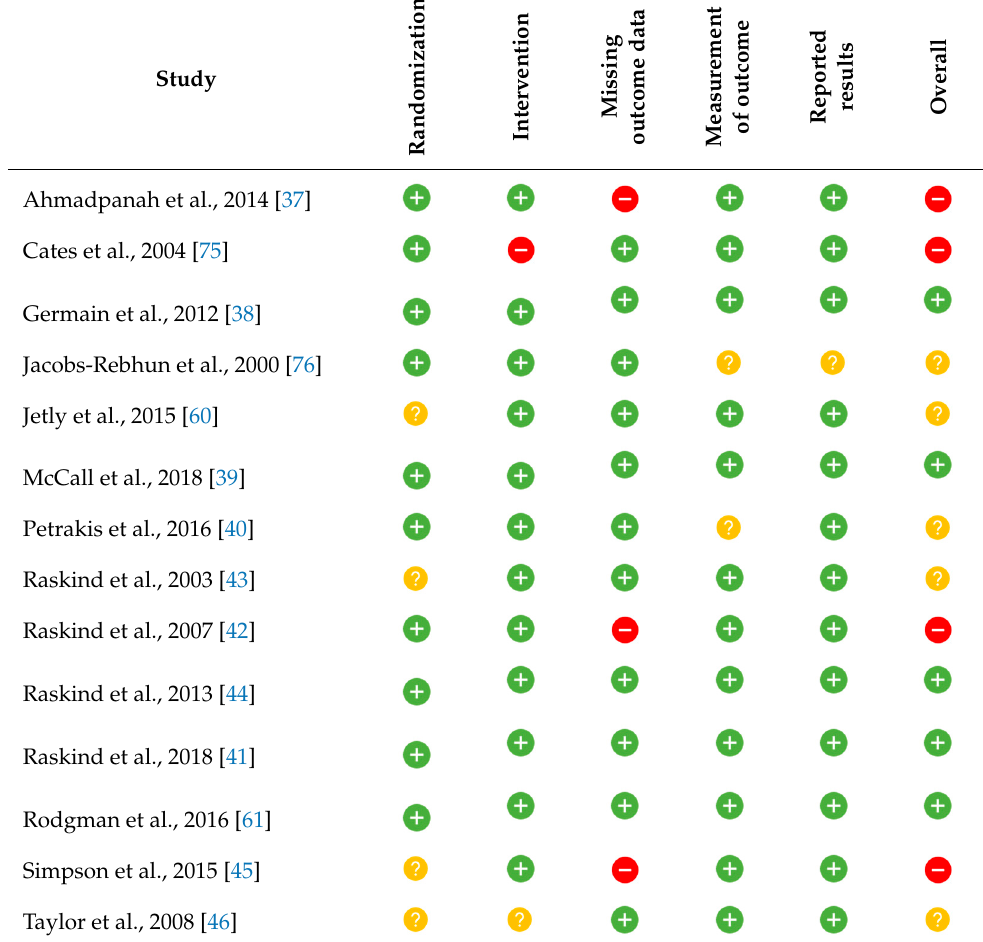
Table 2. Risk of Bias in the Included Table 2. Risk of Bias in the Included Studies. Randomization : biases that unfold in the randomization process. Intervention : biases due to deviations Randomization : biases that unfold in the randomization process. Intervention : biases due to deviations from intended interventions. Missing outcome data: biases due to missing outcome data. Measure- from intended interventions. Missing outcome data: biases due to missing outcome data. Measure- Randomization : biases that unfold in the randomization process. Intervention : biases due to deviations Randomization : biases that unfold in the randomization process. Intervention : biases due to deviations Randomization : biases that unfold in the randomization process. Intervention : biases due to deviations Randomization : biases that unfold in the randomization process. Intervention : biases due to deviations ment of outcome : biases in measurement of outcome. Reported results : biases in the selection process ment of outcome : biases in measurement of outcome. Reported results : biases in the selection process from intended interventions. Missing outcome data: biases due to missing outcome data. Measure- from intended interventions. Missing outcome data: biases due to missing outcome data. Measure- from intended interventions. Missing outcome data: biases due to missing outcome data. Measure- from intended interventions. Missing outcome data: biases due to missing outcome data. Measure- from intended interventions. Missing outcome data: biases due to missing outcome data. Measure- Randomization : biases that unfold in the randomization process. Intervention : biases due to deviations of reported results. Overall : skewness assessment of the study in its entirety. : Low risk : ment of outcome : biases in measurement of outcome. Reported results : biases in the selection process ment of outcome : biases in measurement of outcome. Reported results : biases in the selection process ment of outcome : biases in measurement of outcome. Reported results : biases in the selection process ment of outcome : biases in measurement of outcome. Reported results : biases in the selection process of reported results. Overall : skewness assessment of the study in its entirety. : Low risk : ment of outcome : biases in measurement of outcome. Reported results : biases in the selection process ment of outcome : biases in measurement of outcome. Reported results : biases in the selection process from intended interventions. Missing outcome data: biases due to missing outcome data. Measure- Randomization : biases that unfold in the randomization process. Intervention : biases due to deviations Randomization : biases that unfold in the randomization process. Intervention : biases due to deviations of reported results. Overall : skewness assessment of the study in its entirety. of reported results. Overall : skewness assessment of the study in its entirety. of reported results. Overall : skewness assessment of the study in its entirety. : Low risk : of reported results. Overall : skewness assessment of the study in its entirety. : Low risk : ment of outcome : biases in measurement of outcome. Reported results : biases in the selection process ment of outcome : biases in measurement of outcome. Reported results : biases in the selection process Randomization : biases that unfold in the randomization process. Intervention : biases due to deviations Randomization : biases that unfold in the randomization process. Intervention : biases due to deviations of reported results. Overall : skewness assessment of the study in its entirety. Randomization : biases that unfold in the randomization process. Intervention : biases due to deviations from intended interventions. Missing outcome data: biases due to missing outcome data. Measure- from intended interventions. Missing outcome data: biases due to missing outcome data. Measure- from intended interventions. Missing outcome data: biases due to missing outcome data. Measure- from intended interventions. Missing outcome data: biases due to missing outcome data. Measure- Uncertain of reported results. Overall : skewness assessment of the study in its entirety. of reported results. Overall : skewness assessment of the study in its entirety. from intended interventions. Missing outcome data: biases due to missing outcome data. Measure- ment of outcome : biases in measurement of outcome. Reported results : biases in the selection process ment of outcome : biases in measurement of outcome. Reported results : biases in the selection process Randomization : biases that unfold in the randomization process. Intervention : biases due to deviations Randomization : biases that unfold in the randomization process. Intervention : biases due to deviations Randomization : biases that unfold in the randomization process. Intervention : biases due to deviations ment of outcome : biases in measurement of outcome. Reported results : biases in the selection process ment of outcome : biases in measurement of outcome. Reported results : biases in the selection process ment of outcome : biases in measurement of outcome. Reported results : biases in the selection process from intended interventions. Missing outcome data: biases due to missing outcome data. Measure- from intended interventions. Missing outcome data: biases due to missing outcome data. Measure- from intended interventions. Missing outcome data: biases due to missing outcome data. Measure- of reported results. Overall : skewness assessment of the study in its entirety. : Low risk : of reported results. Overall : skewness assessment of the study in its entirety. : Low risk : of reported results. Overall : skewness assessment of the study in its entirety. : Low risk : of reported results. Overall : skewness assessment of the study in its entirety. : Low risk : ment of outcome : biases in measurement of outcome. Reported results : biases in the selection process ment of outcome : biases in measurement of outcome. Reported results : biases in the selection process ment of outcome : biases in measurement of outcome. Reported results : biases in the selection process of reported results. Overall : skewness assessment of the study in its entirety. : Low risk : from intended interventions. Missing outcome data: biases due to missing outcome data. Measure- from intended interventions. Missing outcome data: biases due to missing outcome data. Measure- Uncertain : High risk. Uncertain : High risk. Uncertain : High risk. Randomization : biases that unfold in the randomization process. Intervention : biases due to deviations Randomization : biases that unfold in the randomization process. Intervention : biases due to deviations Randomization : biases that unfold in the randomization process. Intervention : biases due to deviations Randomization : biases that unfold in the randomization process. Intervention : biases due to deviations of reported results. Overall : skewness assessment of the study in its entirety. of reported results. Overall : skewness assessment of the study in its entirety. ment of outcome : biases in measurement of outcome. Reported results : biases in the selection process ment of outcome : biases in measurement of outcome. Reported results : biases in the selection process ment of outcome : biases in measurement of outcome. Reported results : biases in the selection process Randomization : biases that unfold in the randomization process. Intervention : biases due to deviations Randomization : biases that unfold in the randomization process. Intervention : biases due to deviations from intended interventions. Missing outcome data: biases due to missing outcome data. Measure- from intended interventions. Missing outcome data: biases due to missing outcome data. Measure- from intended interventions. Missing outcome data: biases due to missing outcome data. Measure- from intended interventions. Missing outcome data: biases due to missing outcome data. Measure- from intended interventions. Missing outcome data: biases due to missing outcome data. Measure- from intended interventions. Missing outcome data: biases due to missing outcome data. Measure- of reported results. Overall : skewness assessment of the study in its entirety. of reported results. Overall : skewness assessment of the study in its entirety. : Low risk : ment of outcome : biases in measurement of outcome. Reported results : biases in the selection process ment of outcome : biases in measurement of outcome. Reported results : biases in the selection process ment of outcome : biases in measurement of outcome. Reported results : biases in the selection process ment of outcome : biases in measurement of outcome. Reported results : biases in the selection process Randomization : biases that unfold in the randomization process. Intervention : biases due to deviations Randomization : biases that unfold in the randomization process. Intervention : biases due to deviations Randomization : biases that unfold in the randomization process. Intervention : biases due to deviations Randomization : biases that unfold in the randomization process. Intervention : biases due to deviations ment of outcome : biases in measurement of outcome. Reported results : biases in the selection process ment of outcome : biases in measurement of outcome. Reported results : biases in the selection process from intended interventions. Missing outcome data: biases due to missing outcome data. Measure- from intended interventions. Missing outcome data: biases due to missing outcome data. Measure- from intended interventions. Missing outcome data: biases due to missing outcome data. Measure- from intended interventions. Missing outcome data: biases due to missing outcome data. Measure- of reported results. Overall : skewness assessment of the study in its entirety. of reported results. Overall : skewness assessment of the study in its entirety. : Low risk : of reported results. Overall : skewness assessment of the study in its entirety. : Low risk : of reported results. Overall : skewness assessment of the study in its entirety. : Low risk : Randomization : biases that unfold in the randomization process. Intervention : biases due to deviations Randomization : biases that unfold in the randomization process. Intervention : biases due to deviations Randomization : biases that unfold in the randomization process. Intervention : biases due to deviations Randomization : biases that unfold in the randomization process. Intervention : biases due to deviations of reported results. Overall : skewness assessment of the study in its entirety. : Low risk : of reported results. Overall : skewness assessment of the study in its entirety. ment of outcome : biases in measurement of outcome. Reported results : biases in the selection process ment of outcome : biases in measurement of outcome. Reported results : biases in the selection process ment of outcome : biases in measurement of outcome. Reported results : biases in the selection process ment of outcome : biases in measurement of outcome. Reported results : biases in the selection process from intended interventions. Missing outcome data: biases due to missing outcome data. Measure- from intended interventions. Missing outcome data: biases due to missing outcome data. Measure- from intended interventions. Missing outcome data: biases due to missing outcome data. Measure- from intended interventions. Missing outcome data: biases due to missing outcome data. Measure- Uncertain : High risk. Randomization : biases that unfold in the randomization process. Intervention : biases due to deviations Randomization : biases that unfold in the randomization process. Intervention : biases due to deviations Randomization : biases that unfold in the randomization process. Intervention : biases due to deviations Randomization : biases that unfold in the randomization process. Intervention : biases due to deviations of reported results. Overall : skewness assessment of the study in its entirety. of reported results. Overall : skewness assessment of the study in its entirety. of reported results. Overall : skewness assessment of the study in its entirety. of reported results. Overall : skewness assessment of the study in its entirety. : Low risk : ment of outcome : biases in measurement of outcome. Reported results : biases in the selection process ment of outcome : biases in measurement of outcome. Reported results : biases in the selection process ment of outcome : biases in measurement of outcome. Reported results : biases in the selection process ment of outcome : biases in measurement of outcome. Reported results : biases in the selection process from intended interventions. Missing outcome data: biases due to missing outcome data. Measure- from intended interventions. Missing outcome data: biases due to missing outcome data. Measure- from intended interventions. Missing outcome data: biases due to missing outcome data. Measure- from intended interventions. Missing outcome data: biases due to missing outcome data. Measure- Randomization : biases that unfold in the randomization process. Intervention : biases due to deviations Uncertain Randomization : biases that unfold in the randomization process. Intervention : biases due to deviations Randomization : biases that unfold in the randomization process. Intervention : biases due to deviations Randomization : biases that unfold in the randomization process. Intervention : biases due to deviations of reported results. Overall : skewness assessment of the study in its entirety. : Low risk : of reported results. Overall : skewness assessment of the study in its entirety. : Low risk : of reported results. Overall : skewness assessment of the study in its entirety. : Low risk : of reported results. Overall : skewness assessment of the study in its entirety. : Low risk : ment of outcome : biases in measurement of outcome. Reported results : biases in the selection process ment of outcome : biases in measurement of outcome. Reported results : biases in the selection process ment of outcome : biases in measurement of outcome. Reported results : biases in the selection process ment of outcome : biases in measurement of outcome. Reported results : biases in the selection process Randomization : biases that unfold in the randomization process. Intervention : biases due to deviations from intended interventions. Missing outcome data: biases due to missing outcome data. Measure- from intended interventions. Missing outcome data: biases due to missing outcome data. Measure- from intended interventions. Missing outcome data: biases due to missing outcome data. Measure- from intended interventions. Missing outcome data: biases due to missing outcome data. Measure- from intended interventions. Missing outcome data: biases due to missing outcome data. Measure- from intended interventions. Missing outcome data: biases due to missing outcome data. Measure- ment of outcome : biases in measurement of outcome. Reported results : biases in the selection process Uncertain : High risk. Uncertain : High risk. of reported results. Overall : skewness assessment of the study in its entirety. : Low risk : of reported results. Overall : skewness assessment of the study in its entirety. : Low risk : of reported results. Overall : skewness assessment of the study in its entirety. : Low risk : of reported results. Overall : skewness assessment of the study in its entirety. : Low risk : ment of outcome : biases in measurement of outcome. Reported results : biases in the selection process ment of outcome : biases in measurement of outcome. Reported results : biases in the selection process ment of outcome : biases in measurement of outcome. Reported results : biases in the selection process ment of outcome : biases in measurement of outcome. Reported results : biases in the selection process Randomization : biases that unfold in the randomization process. Intervention : biases due to deviations Randomization : biases that unfold in the randomization process. Intervention : biases due to deviations Randomization : biases that unfold in the randomization process. Intervention : biases due to deviations ment of outcome : biases in measurement of outcome. Reported results : biases in the selection process Taylor et al., 2008 [46] from intended interventions. Missing outcome data: biases due to missing outcome data. Measure- from intended interventions. Missing outcome data: biases due to missing outcome data. Measure- from intended interventions. Missing outcome data: biases due to missing outcome data. Measure- from intended interventions. Missing outcome data: biases due to missing outcome data. Measure- of reported results. Overall : skewness assessment of the study in its entirety. Uncertain : High risk. Uncertain : High risk. Uncertain : High risk. Uncertain : High risk. Taylor et al., 2008 [46] of reported results. Overall : skewness assessment of the study in its entirety. : Low risk : ment of outcome : biases in measurement of outcome. Reported results : biases in the selection process ment of outcome : biases in measurement of outcome. Reported results : biases in the selection process ment of outcome : biases in measurement of outcome. Reported results : biases in the selection process ment of outcome : biases in measurement of outcome. Reported results : biases in the selection process Randomization : biases that unfold in the randomization process. Intervention : biases due to deviations Randomization : biases that unfold in the randomization process. Intervention : biases due to deviations Randomization : biases that unfold in the randomization process. Intervention : biases due to deviations Uncertain Randomization : biases that unfold in the randomization process. Intervention : biases due to deviations Randomization : biases that unfold in the randomization process. Intervention : biases due to deviations Randomization : biases that unfold in the randomization process. Intervention : biases due to deviations from intended interventions. Missing outcome data: biases due to missing outcome data. Measure- from intended interventions. Missing outcome data: biases due to missing outcome data. Measure- from intended interventions. Missing outcome data: biases due to missing outcome data. Measure- Uncertain : High risk. from intended interventions. Missing outcome data: biases due to missing outcome data. Measure- of reported results. Overall : skewness assessment of the study in its entirety. of reported results. Overall : skewness assessment of the study in its entirety. : Low risk : of reported results. Overall : skewness assessment of the study in its entirety. : Low risk : of reported results. Overall : skewness assessment of the study in its entirety. : Low risk : from intended interventions. Missing outcome data: biases due to missing outcome data. Measure- from intended interventions. Missing outcome data: biases due to missing outcome data. Measure- ment of outcome : biases in measurement of outcome. Reported results : biases in the selection process ment of outcome : biases in measurement of outcome. Reported results : biases in the selection process ment of outcome : biases in measurement of outcome. Reported results : biases in the selection process Randomization : biases that unfold in the randomization process. Intervention : biases due to deviations Randomization : biases that unfold in the randomization process. Intervention : biases due to deviations ment of outcome : biases in measurement of outcome. Reported results : biases in the selection process ment of outcome : biases in measurement of outcome. Reported results : biases in the selection process ment of outcome : biases in measurement of outcome. Reported results : biases in the selection process from intended interventions. Missing outcome data: biases due to missing outcome data. Measure- from intended interventions. Missing outcome data: biases due to missing outcome data. Measure- of reported results. Overall : skewness assessment of the study in its entirety. : Low risk : of reported results. Overall : skewness assessment of the study in its entirety. : Low risk : of reported results. Overall : skewness assessment of the study in its entirety. : Low risk : of reported results. Overall : skewness assessment of the study in its entirety. : Low risk : of reported results. Overall : skewness assessment of the study in its entirety. : Low risk : of reported results. Overall : skewness assessment of the study in its entirety. : Low risk : ment of outcome : biases in measurement of outcome. Reported results : biases in the selection process ment of outcome : biases in measurement of outcome. Reported results : biases in the selection process Uncertain : High risk. Uncertain : High risk. Uncertain : High risk. Uncertain : High risk. Uncertain : High risk. Uncertain : High risk. of reported results. Overall : skewness assessment of the study in its entirety. : Low risk : Uncertain : High risk. 3.5. Results at the End of Treatment The results of the 15 pharmacological interventions after treatment (14 studies, N = 830) showed an overall effect size of g = 0.50 (95% CI = 0.14–0.87, p = 0.007). See Figure 2. It should be noted that there was large variation in the effect sizes between the different studies manifested by a Cochran’s Q of 83.1 ( df = 14, p < 0.01), which indicates significant heterogeneity. The I 2 suggested that 83.2% of the variation in effect sizes reflects real var- iation. Following the Knapp–Hartung adjustment [72], the 95% CI interval became wider (0.06–0.95, p = 0.029), but the overall effect size was still significant. When only including studies with low risk of bias (k = 5), the overall effect size became non-significant ( g = 0.11, 95% CI = − 0.44–0.67, p = 0.690). of reported results. Overall : skewness assessment of the study in its entirety. : Low risk : Uncertain : High risk. 3.5. Results at the End of Treatment The results of the 15 pharmacological interventions after treatment (14 studies, N = 830) showed an overall effect size of g = 0.50 (95% CI = 0.14–0.87, p = 0.007). See Figure 2. It should be noted that there was large variation in the effect sizes between the different studies manifested by a Cochran’s Q of 83.1 ( df = 14, p < 0.01), which indicates significant heterogeneity. The I 2 suggested that 83.2% of the variation in effect sizes reflects real var- iation. Following the Knapp–Hartung adjustment [72], the 95% CI interval became wider (0.06–0.95, p = 0.029), but the overall effect size was still significant. When only including studies with low risk of bias (k = 5), the overall effect size became non-significant ( g = 0.11, 95% CI = − 0.44–0.67, p = 0.690). 3.5. Results at the End of Treatment The results of the 15 pharmacological interventions after treatment (14 studies, N = 830) showed an overall effect size of g = 0.50 (95% CI = 0.14–0.87, p = 0.007). See Figure 2. It should be noted that there was large variation in the effect sizes between the different studies manifested by a Cochran’s Q of 83.1 ( df = 14, p < 0.01), which indicates significant heterogeneity. The I 2 suggested that 83.2% of the variation in effect sizes reflects real var- iation. Following the Knapp–Hartung adjustment [72], the 95% CI interval became wider (0.06–0.95, p = 0.029), but the overall effect size was still significant. When only including studies with low risk of bias (k = 5), the overall effect size became non-significant ( g = 0.11, 95% CI = − 0.44–0.67, p = 0.690). 3.5. Results at the End of Treatment The results of the 15 pharmacological interventions after treatment (14 studies, N = 830) showed an overall effect size of g = 0.50 (95% CI = 0.14–0.87, p = 0.007). See Figure 2. It should be noted that there was large variation in the effect sizes between the different studies manifested by a Cochran’s Q of 83.1 ( df = 14, p < 0.01), which indicates significant heterogeneity. The I 2 suggested that 83.2% of the variation in effect sizes reflects real var- iation. Following the Knapp–Hartung adjustment [72], the 95% CI interval became wider (0.06–0.95, p = 0.029), but the overall effect size was still significant. When only including studies with low risk of bias (k = 5), the overall effect size became non-significant ( g = 0.11, 95% CI = − 0.44–0.67, p = 0.690). 3.5. Results at the End of Treatment The results of the 15 pharmacological interventions after treatment (14 studies, N = 830) showed an overall effect size of g = 0.50 (95% CI = 0.14–0.87, p = 0.007). See Figure 2. It should be noted that there was large variation in the effect sizes between the different studies manifested by a Cochran’s Q of 83.1 ( df = 14, p < 0.01), which indicates significant heterogeneity. The I 2 suggested that 83.2% of the variation in effect sizes reflects real var- iation. Following the Knapp–Hartung adjustment [72], the 95% CI interval became wider (0.06–0.95, p = 0.029), but the overall effect size was still significant. When only including studies with low risk of bias (k = 5), the overall effect size became non-significant ( g = 0.11, 95% CI = − 0.44–0.67, p = 0.690). 3.5. Results at the End of Treatment The results of the 15 pharmacological interventions after treatment (14 studies, N = 830) showed an overall effect size of g = 0.50 (95% CI = 0.14–0.87, p = 0.007). See Figure 2. It should be noted that there was large variation in the effect sizes between the different studies manifested by a Cochran’s Q of 83.1 ( df = 14, p < 0.01), which indicates significant heterogeneity. The I 2 suggested that 83.2% of the variation in effect sizes reflects real var- iation. Following the Knapp–Hartung adjustment [72], the 95% CI interval became wider (0.06–0.95, p = 0.029), but the overall effect size was still significant. When only including studies with low risk of bias (k = 5), the overall effect size became non-significant ( g = 0.11, 95% CI = − 0.44–0.67, p = 0.690). 3.5. Results at the End of Treatment The results of the 15 pharmacological interventions after treatment (14 studies, N = 830) showed an overall effect size of g = 0.50 (95% CI = 0.14–0.87, p = 0.007). See Figure 2. It should be noted that there was large variation in the effect sizes between the different studies manifested by a Cochran’s Q of 83.1 ( df = 14, p < 0.01), which indicates significant heterogeneity. The I 2 suggested that 83.2% of the variation in effect sizes reflects real var- iation. Following the Knapp–Hartung adjustment [72], the 95% CI interval became wider (0.06–0.95, p = 0.029), but the overall effect size was still significant. When only including studies with low risk of bias (k = 5), the overall effect size became non-significant ( g = 0.11, 95% CI = − 0.44–0.67, p = 0.690). 3.5. Results at the End of Treatment The results of the 15 pharmacological interventions after treatment (14 studies, N = 830) showed an overall effect size of g = 0.50 (95% CI = 0.14–0.87, p = 0.007). See Figure 2. It should be noted that there was large variation in the effect sizes between the different studies manifested by a Cochran’s Q of 83.1 ( df = 14, p < 0.01), which indicates significant heterogeneity. The I 2 suggested that 83.2% of the variation in effect sizes reflects real var- iation. Following the Knapp–Hartung adjustment [72], the 95% CI interval became wider (0.06–0.95, p = 0.029), but the overall effect size was still significant. When only including studies with low risk of bias (k = 5), the overall effect size became non-significant ( g = 0.11, 95% CI = − 0.44–0.67, p = 0.690).